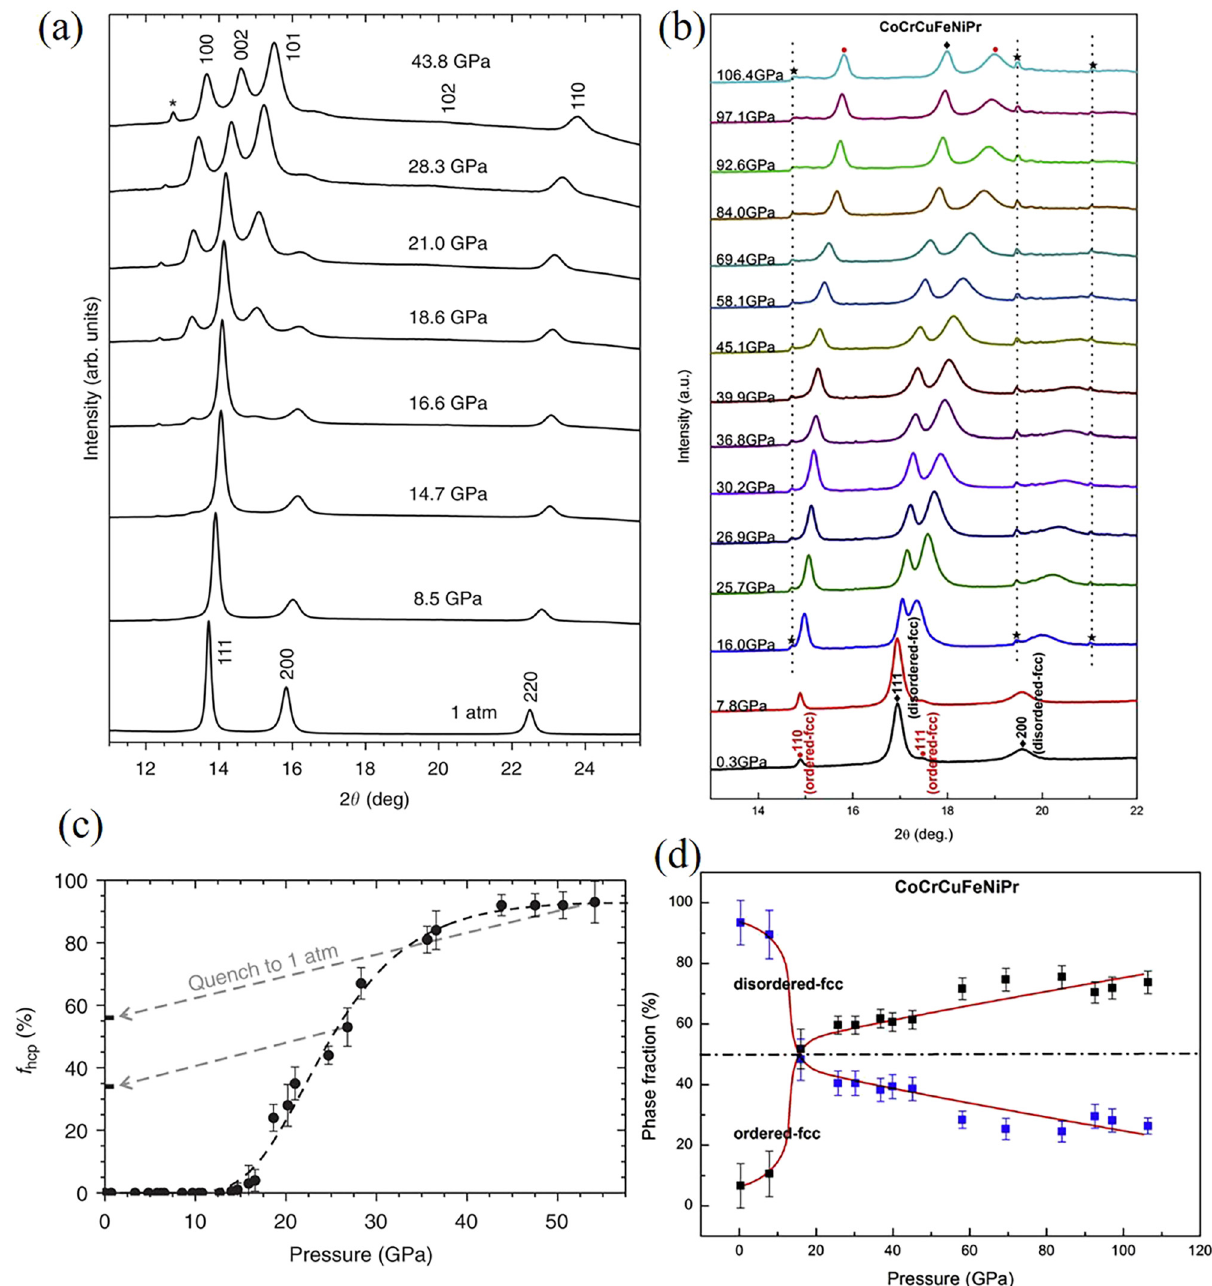
Figure 7: In situ high - pressure x - ray di ff raction patterns and phase fractions with pressure, ( a and c ) CrMnFeCoNi [ 24 ] and ( b and d ) CoCrCuFeNiPr [ 99 ]